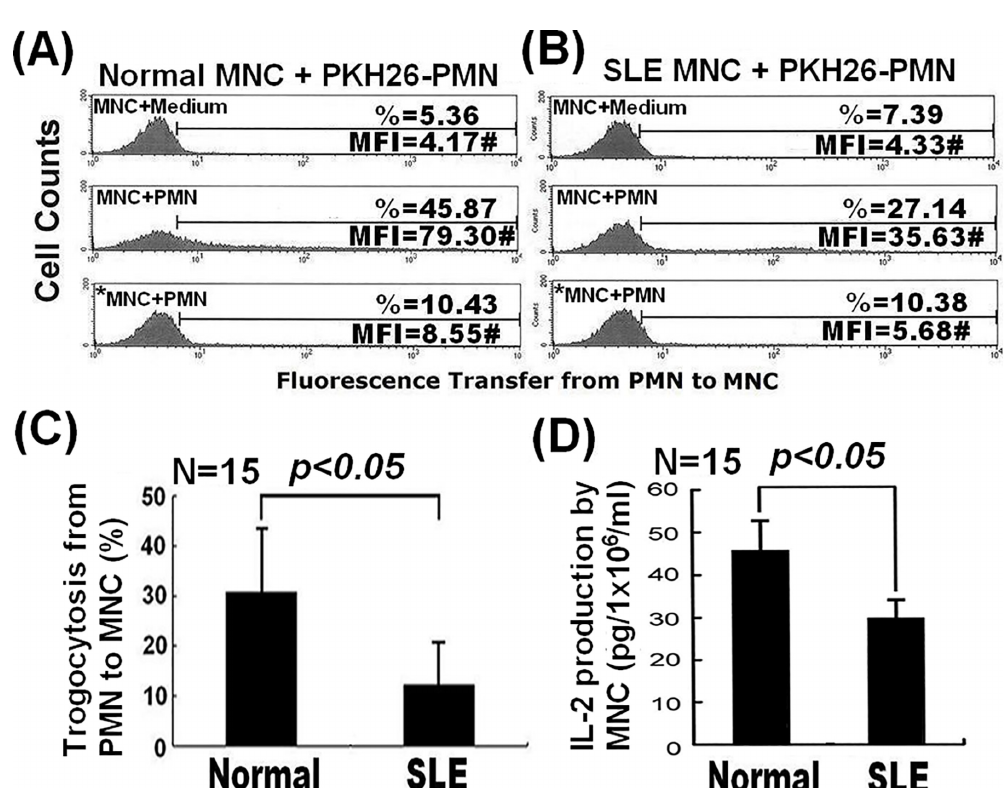
Fig 7. Comparative total membrane transfer from PMNs to MNCs and effects on IL-2 production by MNCs in active SLE versus healthy controls. Results of FACS analysis of representative cases showing (A) the proportion of total membrane transfer from PMNs to MNCs using cells from a healthy individual and (B) the proportion of total membrane transfer from PMNs to MNCs in a patient with active SLE. (C) Comparative proportion of total membrane transfer from PMNs to MNCs in patients with active SLE versus healthy controls. (D) Comparative IL-2 production in normal and active SLE